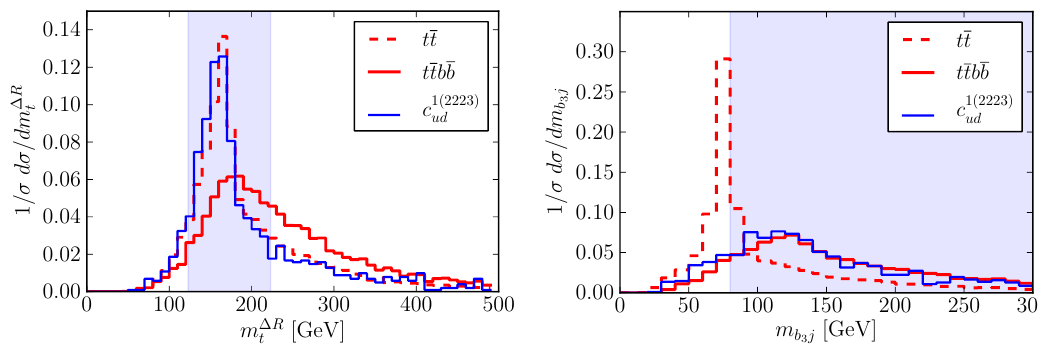
Figure 2 . Normalized distributions of m (cid:1) R and the two main backgrounds: tt (thin dashed red) and ttbb (thick solid red). The cut imposed in our analysis is represented by the blue shaded area.